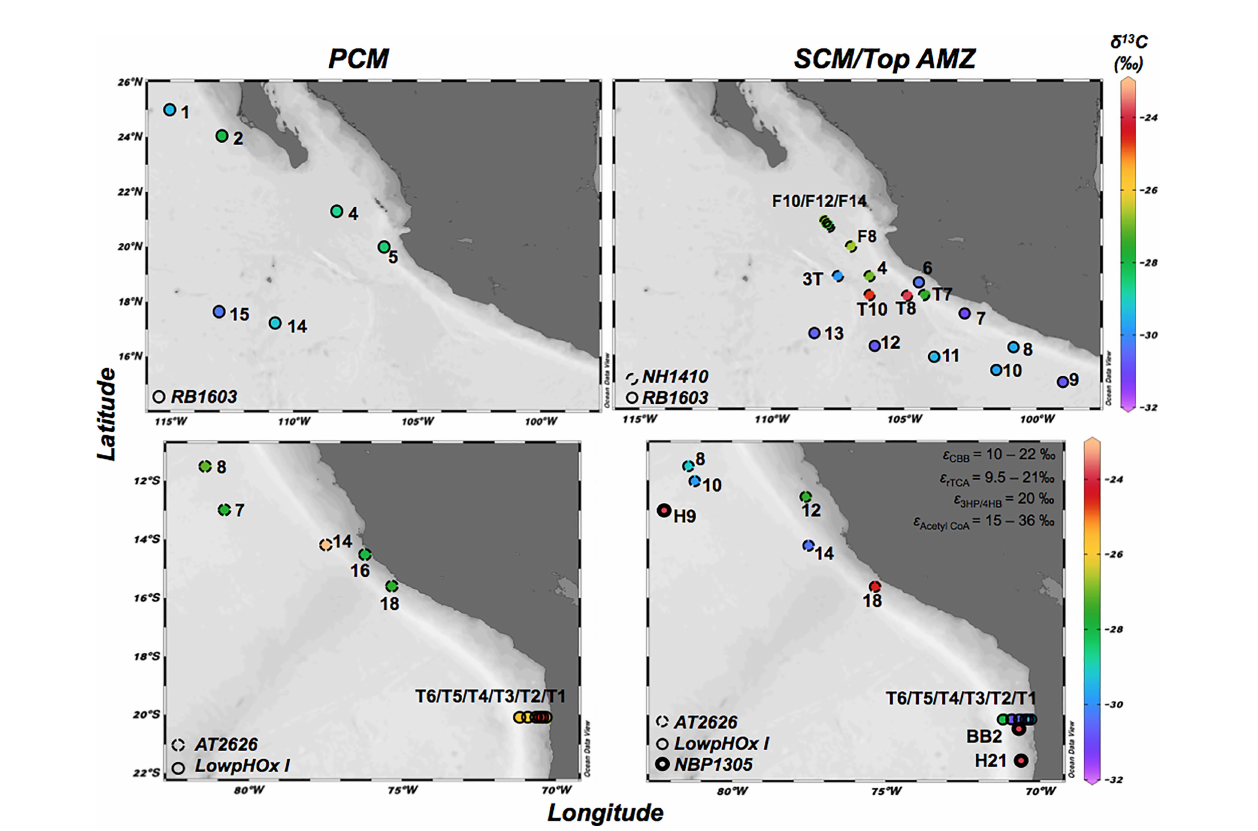
FIGURE 1 | Map with the sampled stations in the ETNP (cruises: NH14010 and RB1603) and the ETSP (cruises: NBP1305, AT2626 and LowpHOx I). Colors indicate d 13 C ( ‰ ) of POC (0.3 – 3.0 m m size fraction) in the primary chlorophyll maximum (PCM) (left panels), and in the secondary chlorophyll maximum (SCM) and top AMZ when no SCM was present (right panels). ϵ indicates the isotopic discrimination of the enzymes involved in the Calvin Benson Bassham (CBB) cycle, reductive Tricarboxylic Acid (rTCA) cycle, 3-hydroxypropionate/4-hydroxybutyrate (3HP/4HB) cycles and Acetyl CoA